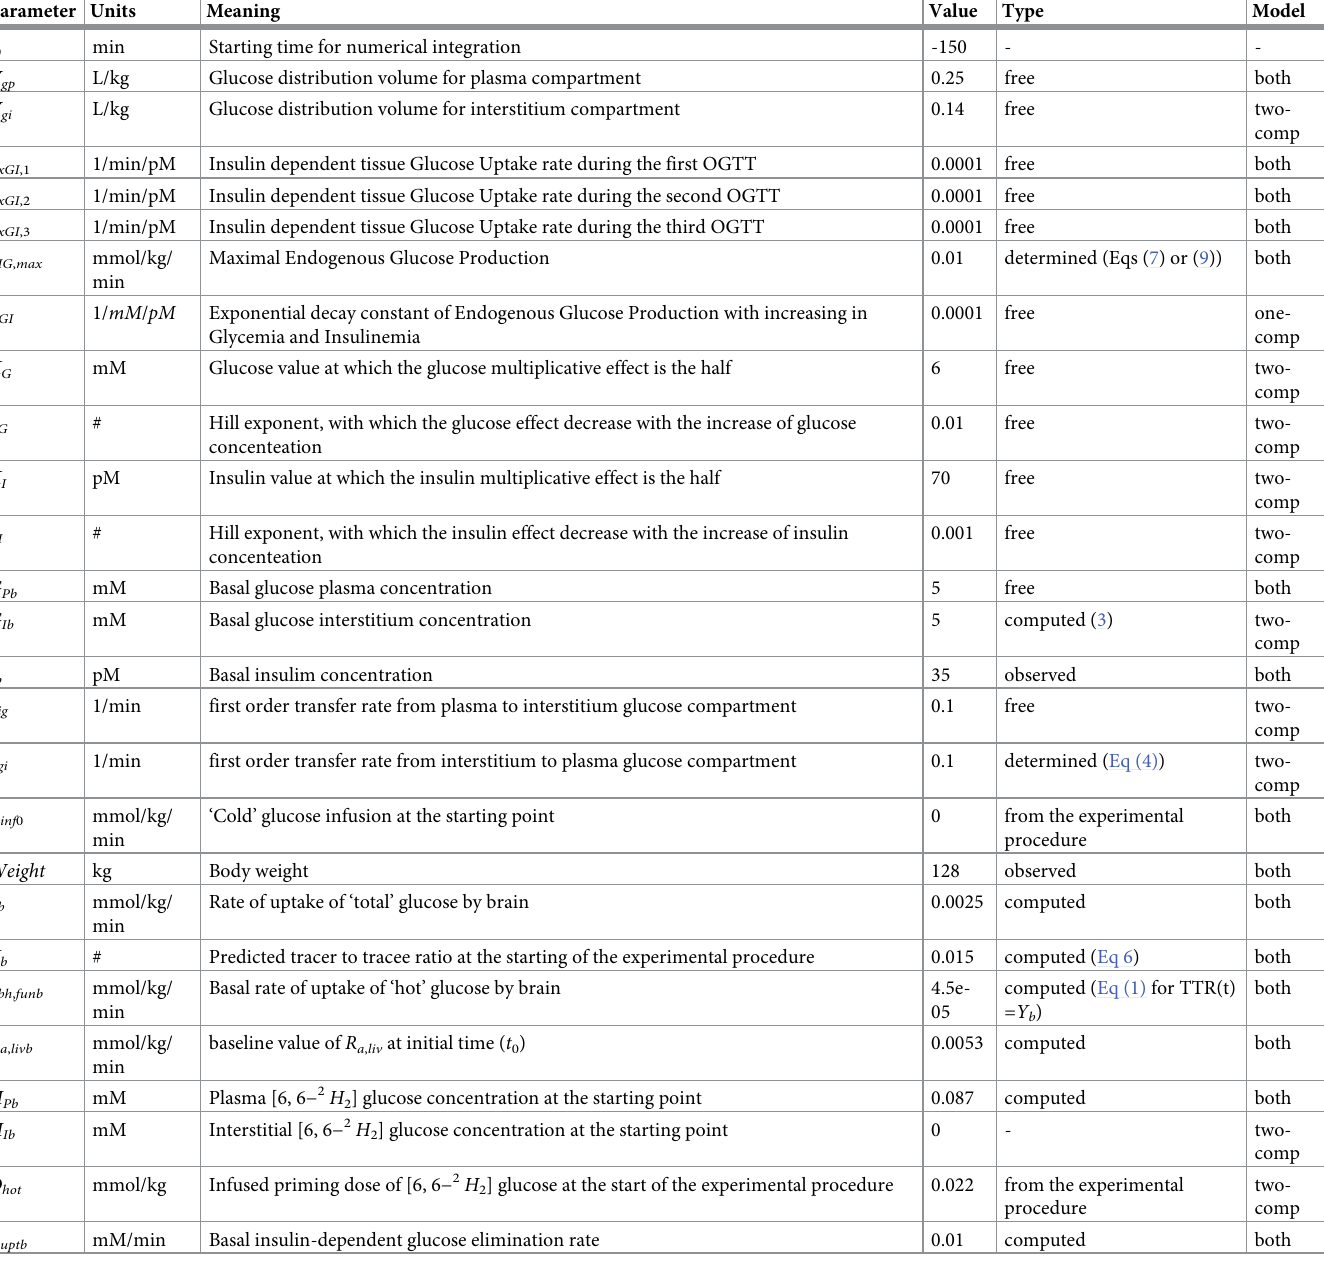
Table 3. Model parameters along with their unit of measurement, description and typical value. Parameter